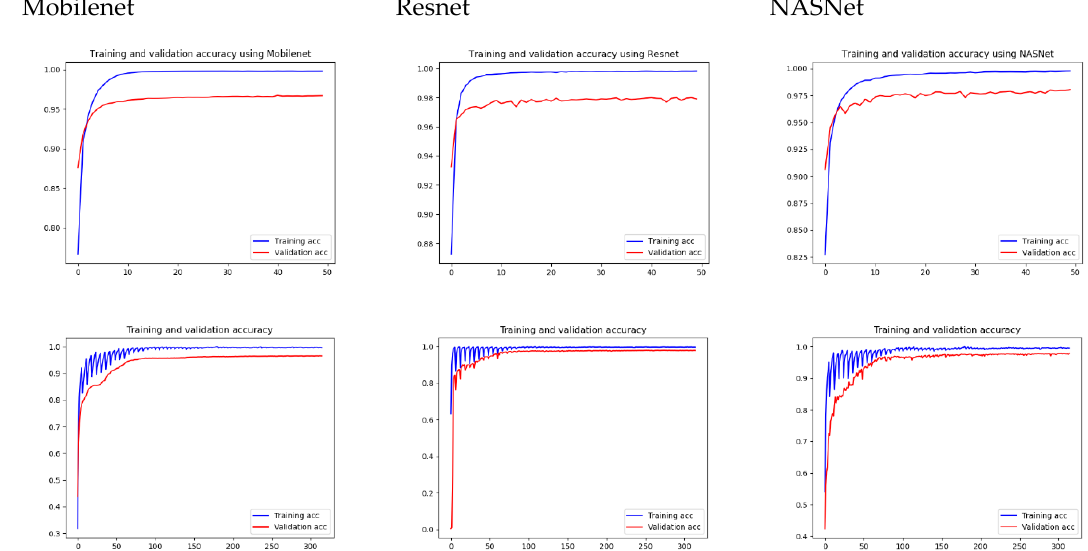
Figure 11. Performance of models trained on the CNU Weeds dataset using the conventional training strategy (upper row) and the YMufT strategy (lower rows).